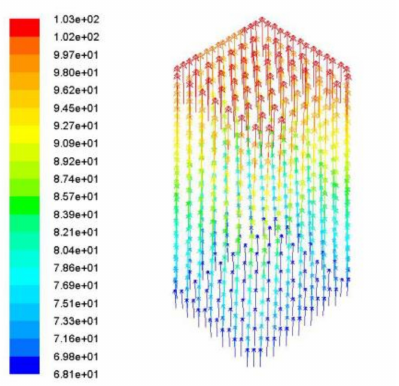
Figure 6. Simulation of 1.6 × 10 2 × 1.6 × 10 2 mm airduct.